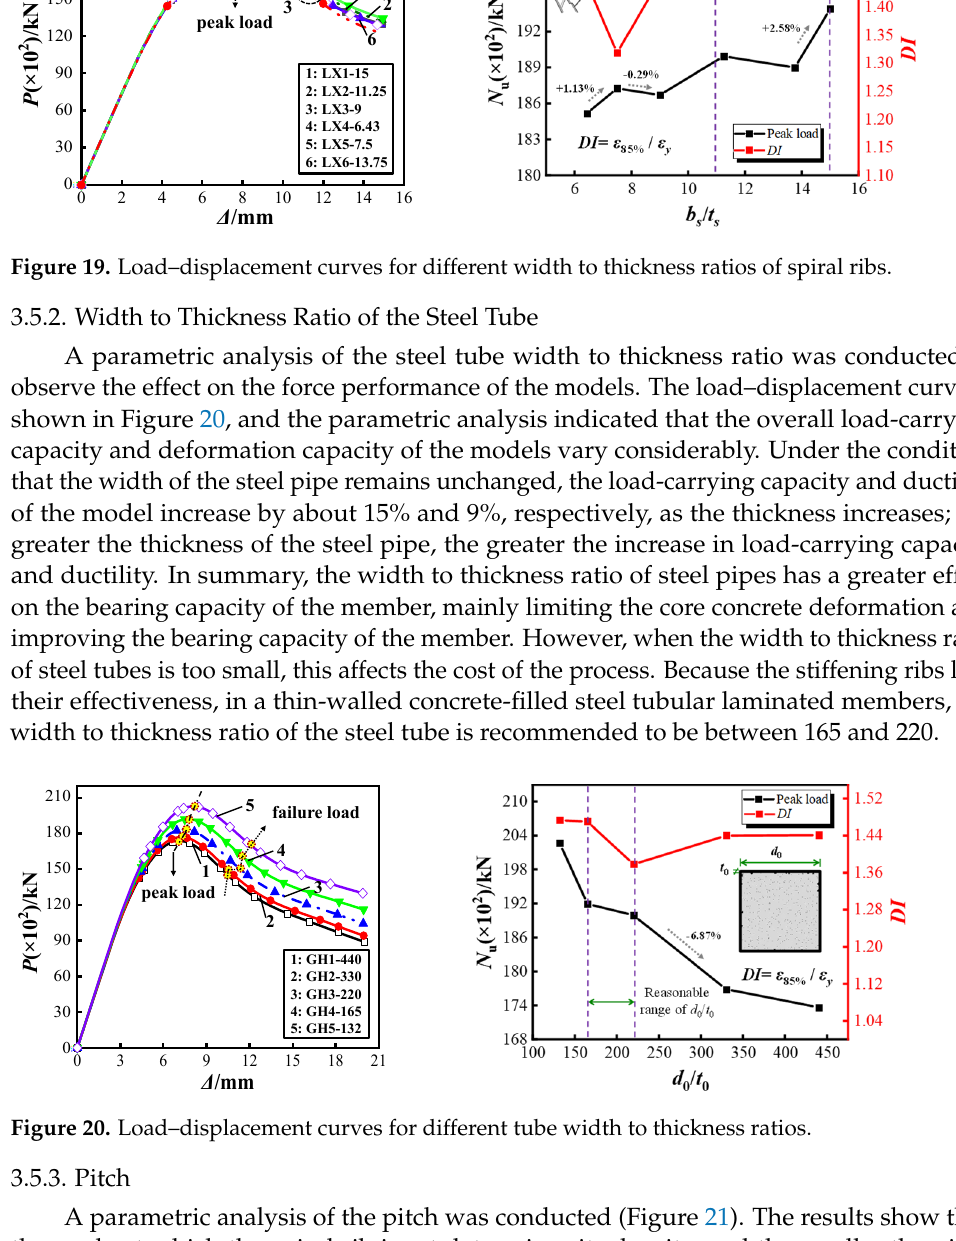
Figure 21. Load–displacement curves with different pitches. 3.5.4. Vertical Steel Bar Diameter A parametric analysis of the vertical reinforcement diameters was conducted (Figure 22), showing that the diameter of the reinforcement has no significant effect on the overall load-bearing capacity and ductility. However, too large or too small a diameter of rein- forcement will affect the cracking of the external concrete, thus affecting the overall load- bearing performance. Reinforcing bars are used as external concrete construction measures. Overall, it is recommended that the spacing should not be greater than 250 mm, and the diameter of the reinforcing bars should be 7/100 to 11/100 of the spacing.